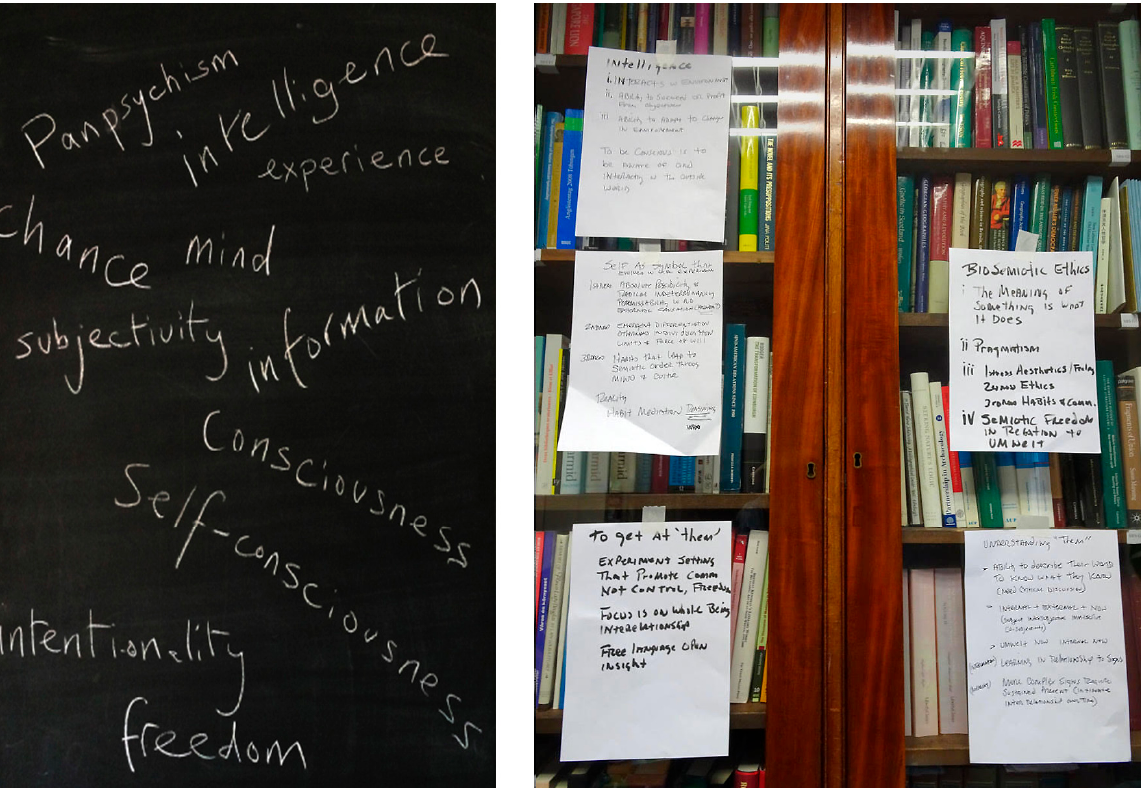
Figure 1. Collective thoughts during the ‘Living Organisms and their Choices’ workshop, 2019. (Courtesy of Collins and Goto Studio: Tim Collins).